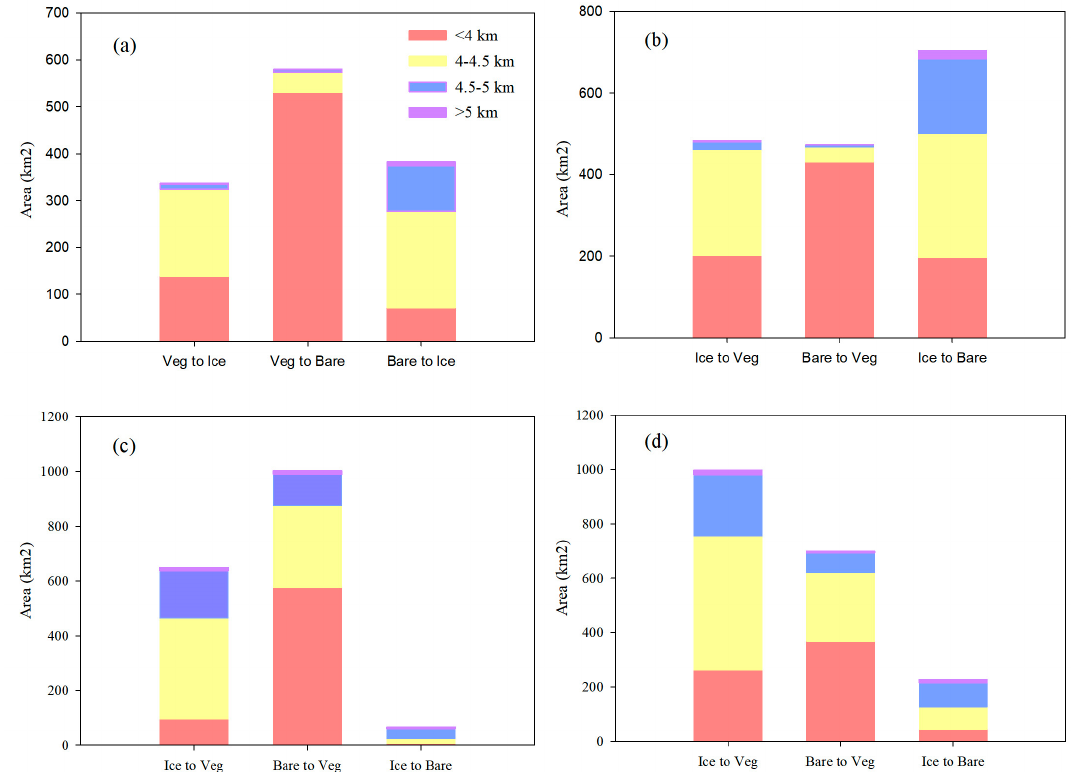
Figure 7. Area conversion diagram of the land cover types (vegetation, ice, and bare land) at different elevations in different years. ( a ) 1990 to 2000; ( b ) 2000 to 2007; ( c ) 2007 to 2016; ( d ) 2007 to 2016. Besides, “Veg” means vegetation, “Bare” means bare land, and “Ice” means ice.